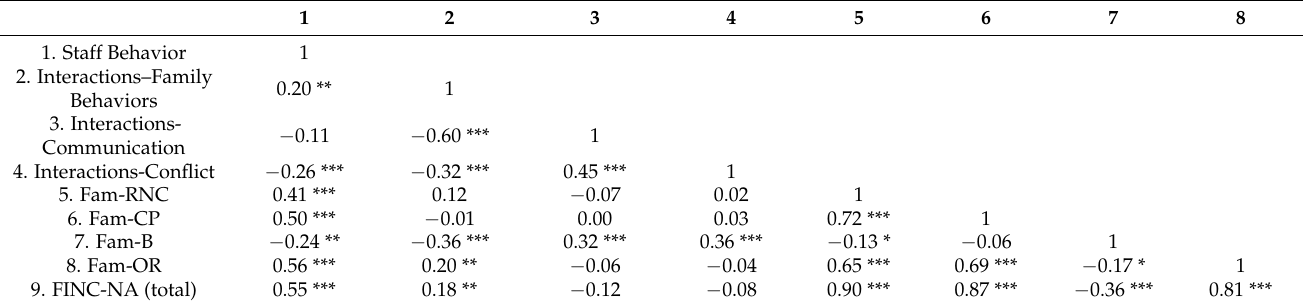
Table 2. Pearson Correlations between Study Measures ( N =